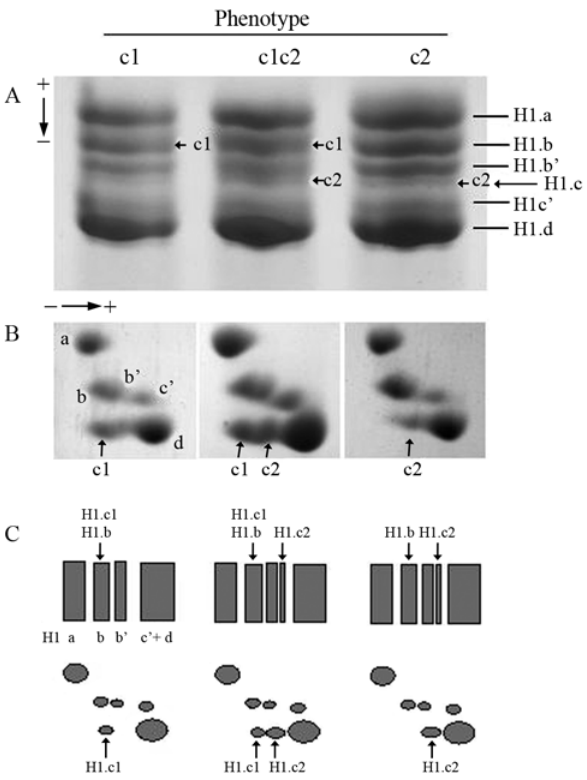
Figure 1 - Phenotypic variation of pheasant histone H1.c in one-di- mensional (A) and two-dimensional (B) gels. Identified phenotypes of histone H1.c (c1, c2 and c1c2) are composed of a single band (A) or spot (B)ofallelicisoformH1.c1(homozygousphenotypec1)orallelicisoform H1.c2 (homozygous phenotype c2), or a double band (A) or spot (B) con- taining both isoforms H1.c1 and H1.c2 (heterozygous phenotype c1c2). In the acetic acid-urea gel, the isoform H1.c1, comigrating with subtype H1.b, moved slower than the fast isoform H1.c2, migrating slightly below subtype H1.b’, while both variants exhibited the same rate of electropho- retic migration (and presumably similar molecular weights) in the SDS gel, but were differently located in relation to the H1.d spot